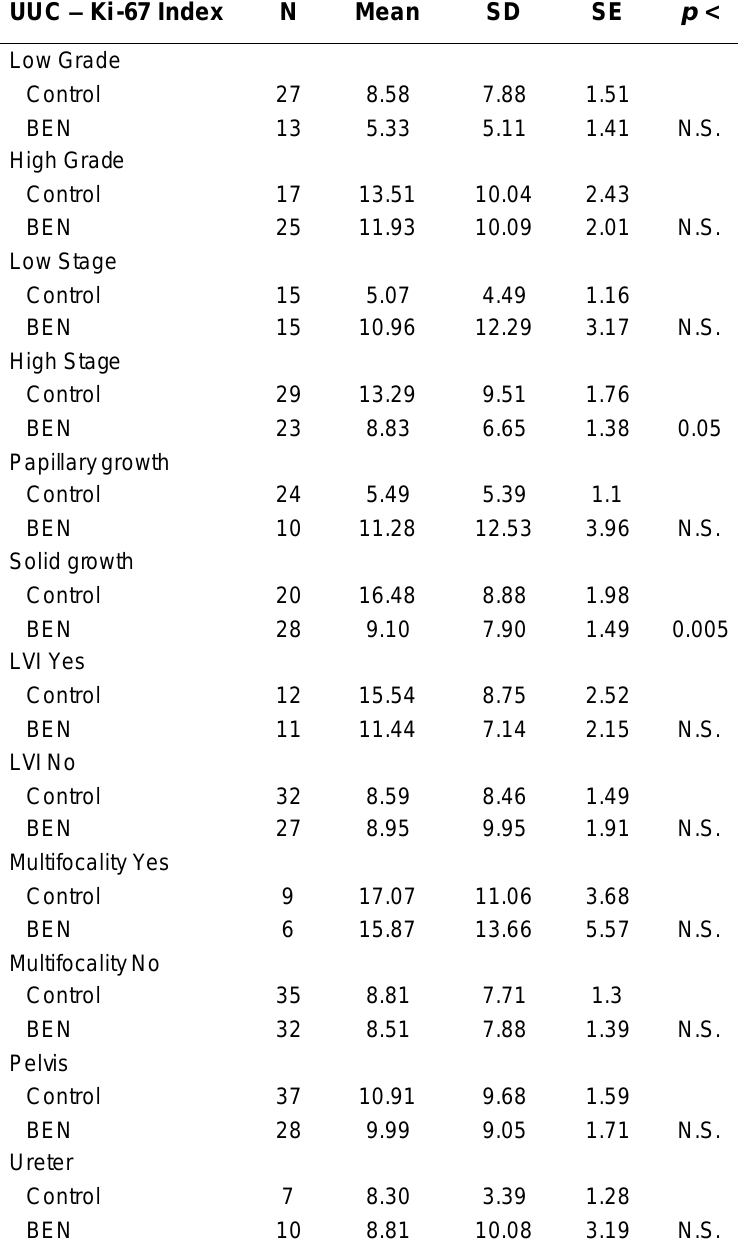
Proliferative Activity Ki-67 in Control and BEN UUC in Relation to Pathological